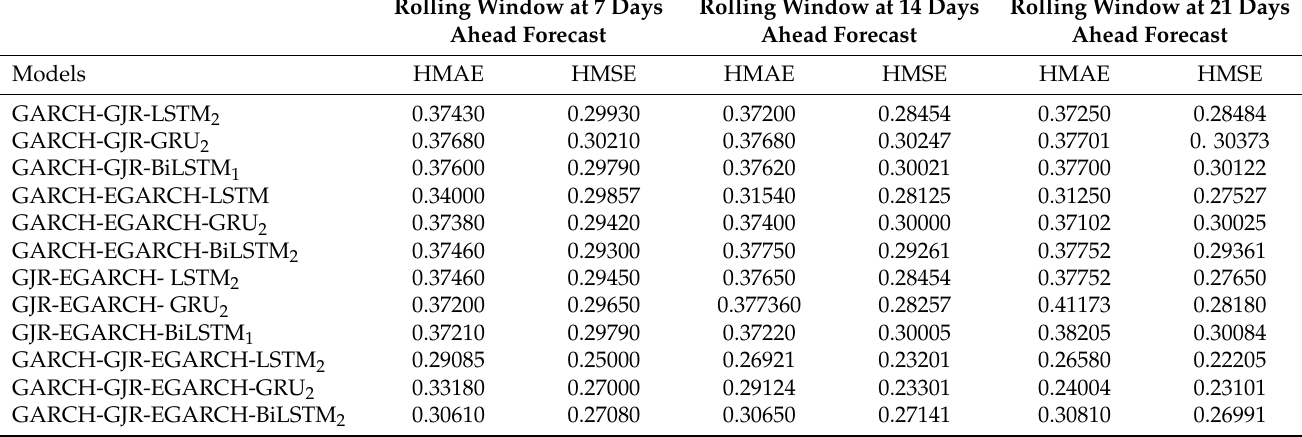
Table 6. Out-of-sample forecast results for double and triple GARCH-type models hybrid with DL models, with fixed rolling window sizes at different forecasts horizons. One Day Rolling Window at 7 Days